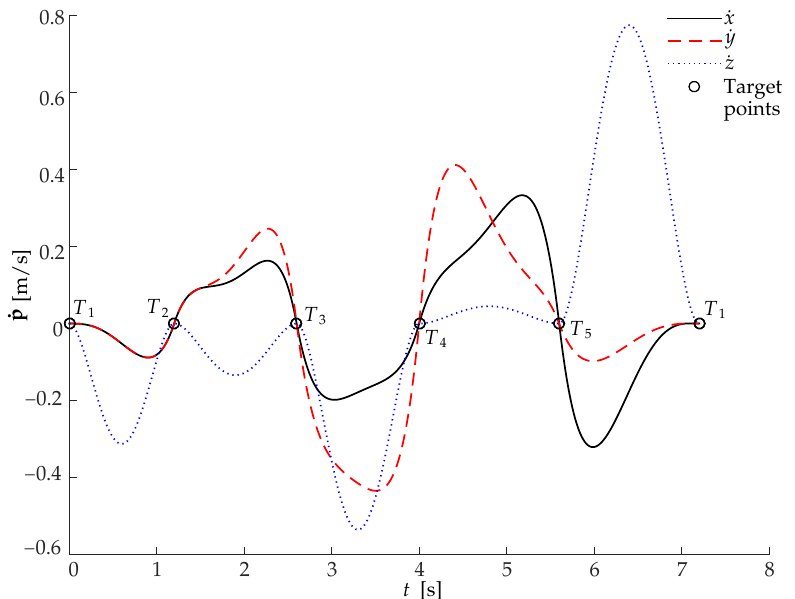
Figure 10. As Figure 9, for the trajectory defined by fifth-order polynomial